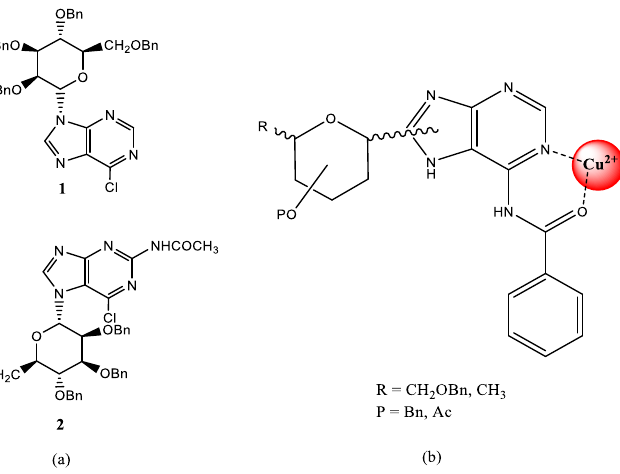
Figure 1. ( a ) Structure of the cholinesterase inhibitors 1 and 2 [19]; ( b ) General structure of the hypothesized purine nucleosides’ copper complex.